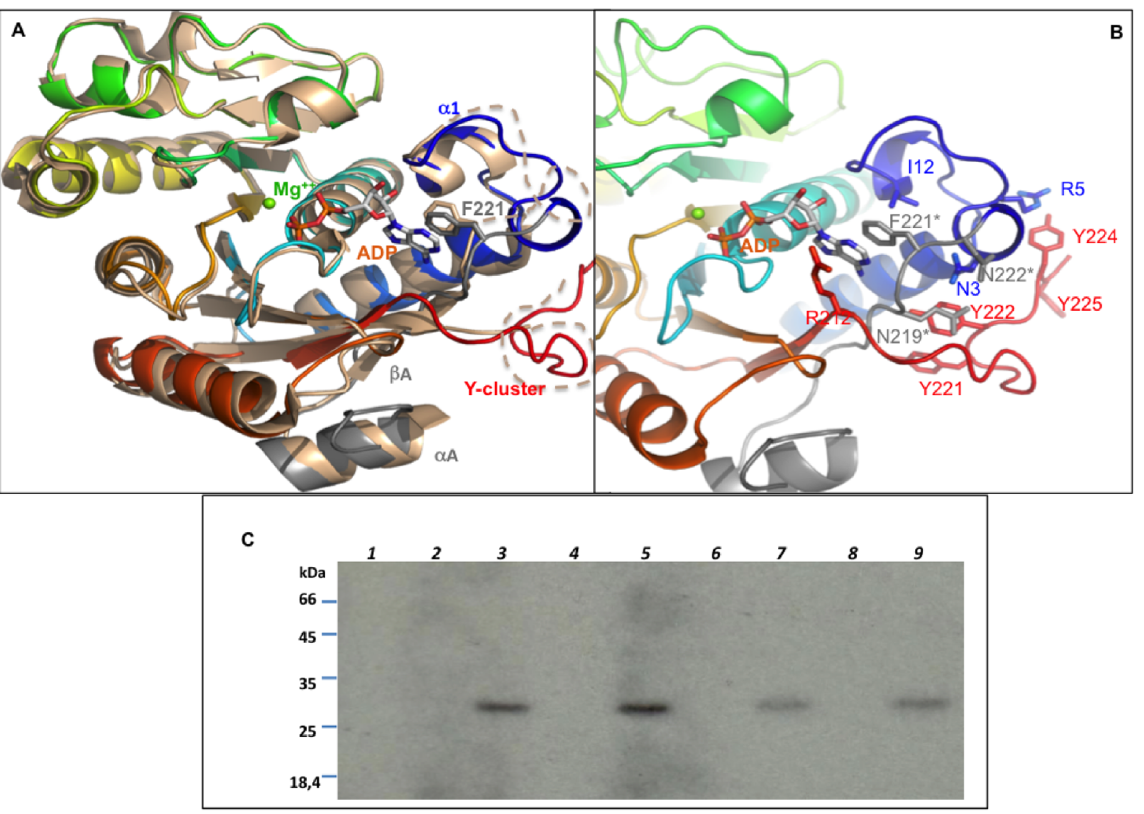
Figure 4. Comparison CapA1B2/CapA2B2. A – Superimposition of the CapA2B2 structure on a monomer from the CapA1B2(K55M)/ADP-Mg octamer (PDB ID 2VED). The proteins are shown as cartoon. CapA1B2(K55M) is colored by spectrum from blue to red. The CapA1 region is highlighted in grey and labeled ( a A, b A). The CapA2B2 structure is colored in wheat. The disordered Y-cluster and loop b A- a 1 are highlighted as dashed lines. Residues F221* from CapA1 and F220 from CapA2 are shown in sticks as well as the ADP molecule bound in the CapA1B2(K55M) structure. B – Interaction networks of the CapA1 C-terminus and of the CapB2 N-terminus. Close view of the CapA1B2(K55M) structure shown in cartoon colored by spectrum. The bound ADP is shown in sticks with the Mg 2 + ion as a green sphere. Residues discussed in the text are highlighted in sticks. CapA1 residues are labeled with a star. C – Effect of CapA1 residue Asn222 on CapB2 activity. CapB2 was incubated in the presence of radioactive ATP and different (wild type or mutated) CapA1 or CapA2 cytoplasmic C-terminal end peptides (CapA1Ct and CapA2Ct). CapB2 autophosphorylation was then analyzed by SDS-PAGE and autoradiography. (lane 1) CapB2; (lane 2) CapA1Ct; (lane 3) CapB2 and CapA1Ct; (lane 4) CapA1Ct deleted from Asn222 (CapA1Ct D N222); (lane 5) CapB2 and CapA1Ct D N222; (lane 6) CapA2Ct; (lane 7) CapB2 and CapA2Ct; (lane 8) CapA2Ct with a C-terminal additional Asn221 (CapA2Ct + N221); (lane 9) CapB2 and CapA2Ct + N221.